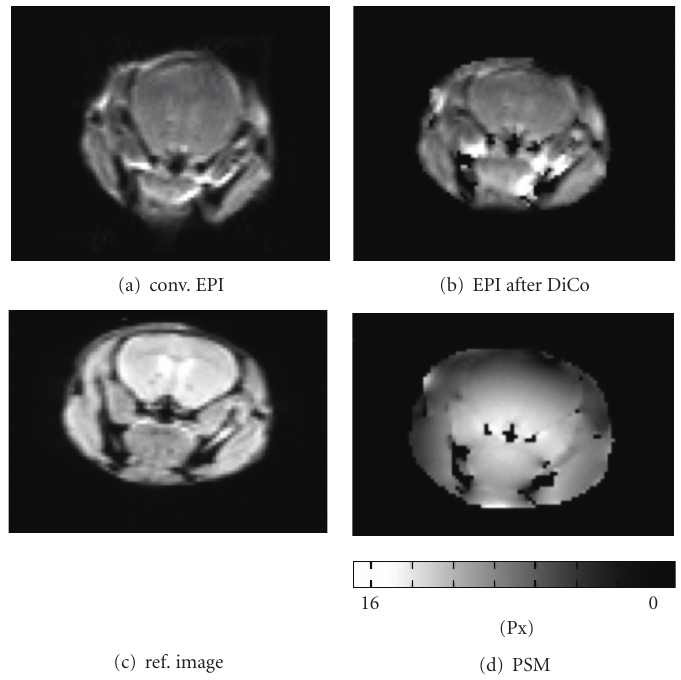
Figure 4: Exemplary results from di ff usion-weighted EPI (DWI-EPI with b = 600s/mm 2 ) acquired in mice (in vivo). The conventional EPI (a) shows strong distortions and an “inflated” brain. The corresponding corrected image (b) shows a clearly improved representation of the brain area. The nondistorted image (c) and the PSM (d) are given in the lower row. Note that an artifact in the distortion corrected image in the area without PSM information. However, the artifact is outside the brain area and does not influence other structures.